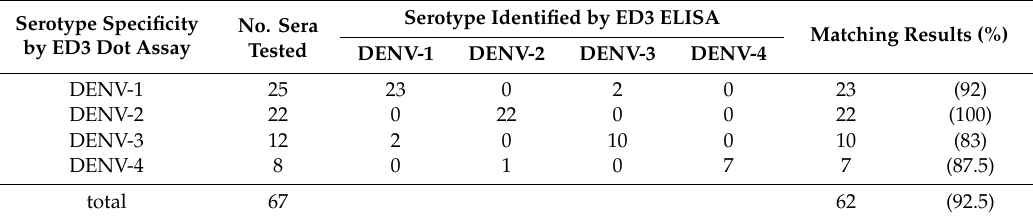
Table 2. Comparison of test results between ED3 dot assay and ED3 Enzyme-linked Immunosorbent Assay